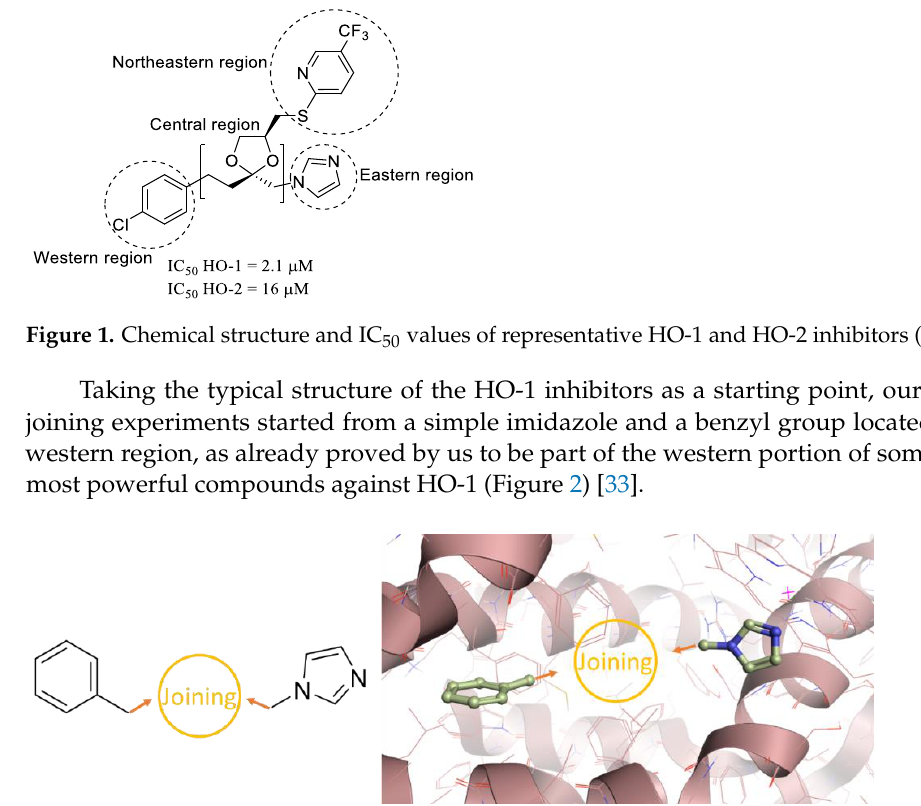
Figure 2. Representation of the ligand-joining experiments inside HO-1.